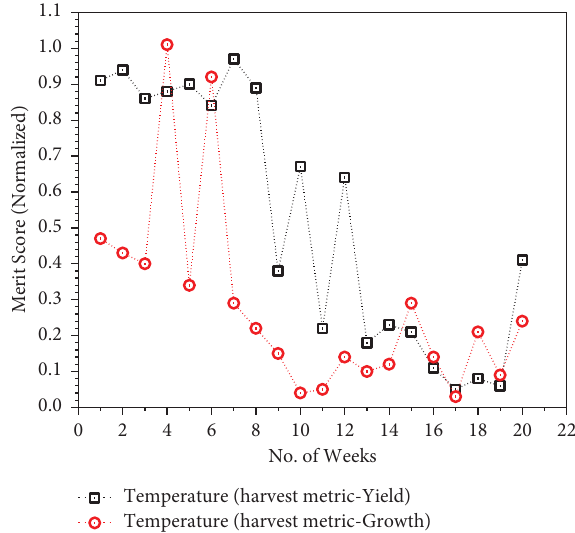
Figure 8: Impact of temperature variable at every point in time between stocking as well as harvesting date when harvest metric taken as yield and growth